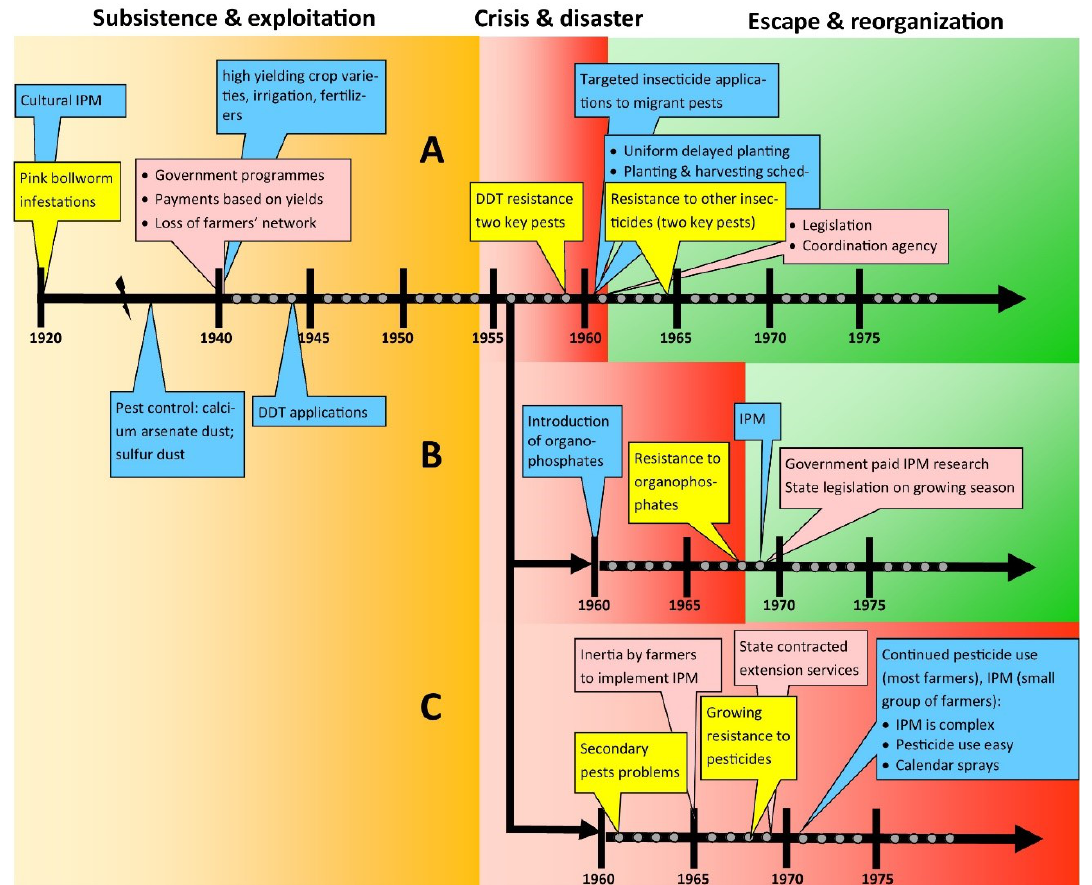
Figure A1.1 : Timeline representing enabling and disabling drivers (text balloons) of pesticide use in cotton production in Texas, USA from 1920-1980. Colours referring to domains in the framework: farming (yellow), agro-landscapes ( green), science & technology (blue), and society (pink). The colours in the background (orange-red-green) indicate the transition to a new phase of the